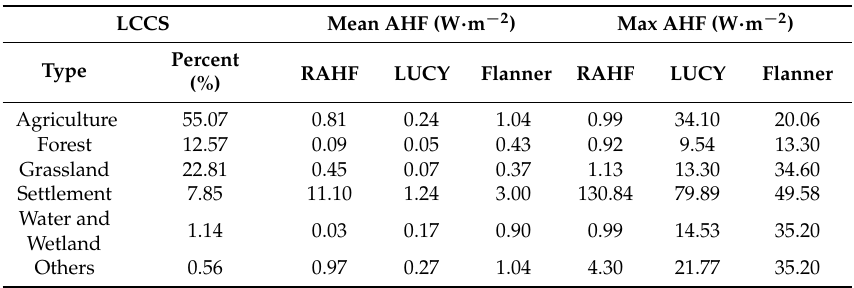
Table 5. The mean and maximum values of different AHF results for different land cover types.